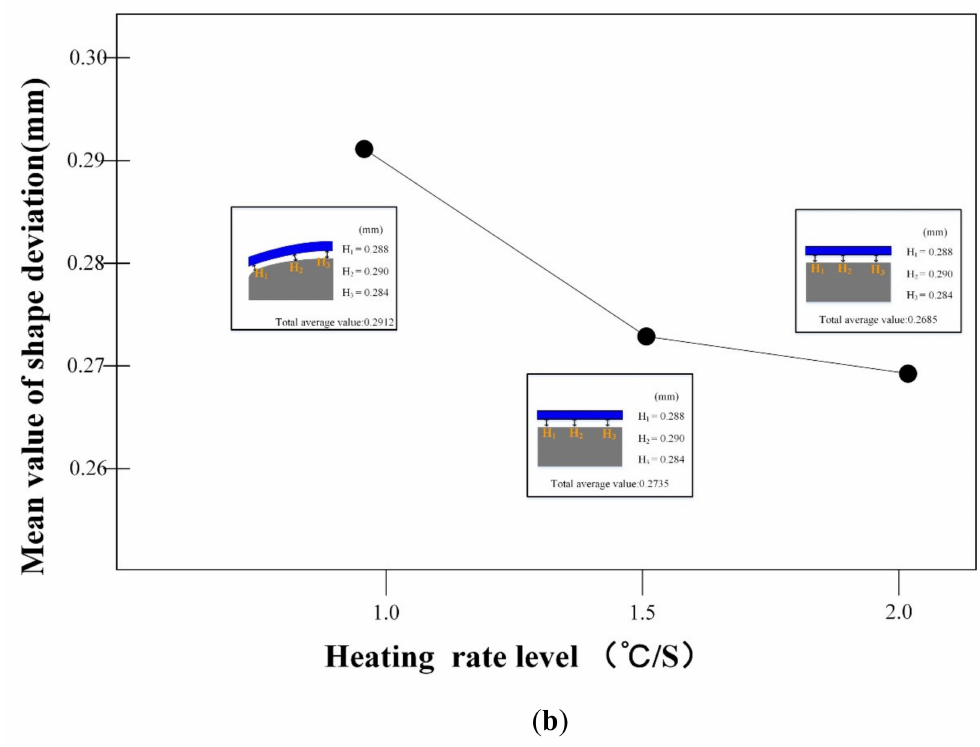
Figure 13. Effect of heating rate on residual stress. ( a ) Effect of heating rate on residual stress; ( b ) Effect of heating rate on shape deviation.